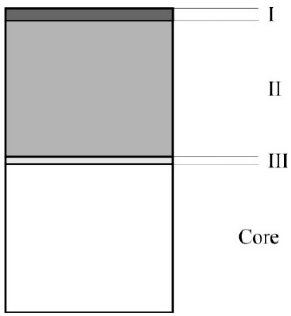
Figure 12. Scheme of microstructure of gas-nitrided layers on Nanoflex precipitation-hardening stainless steel.